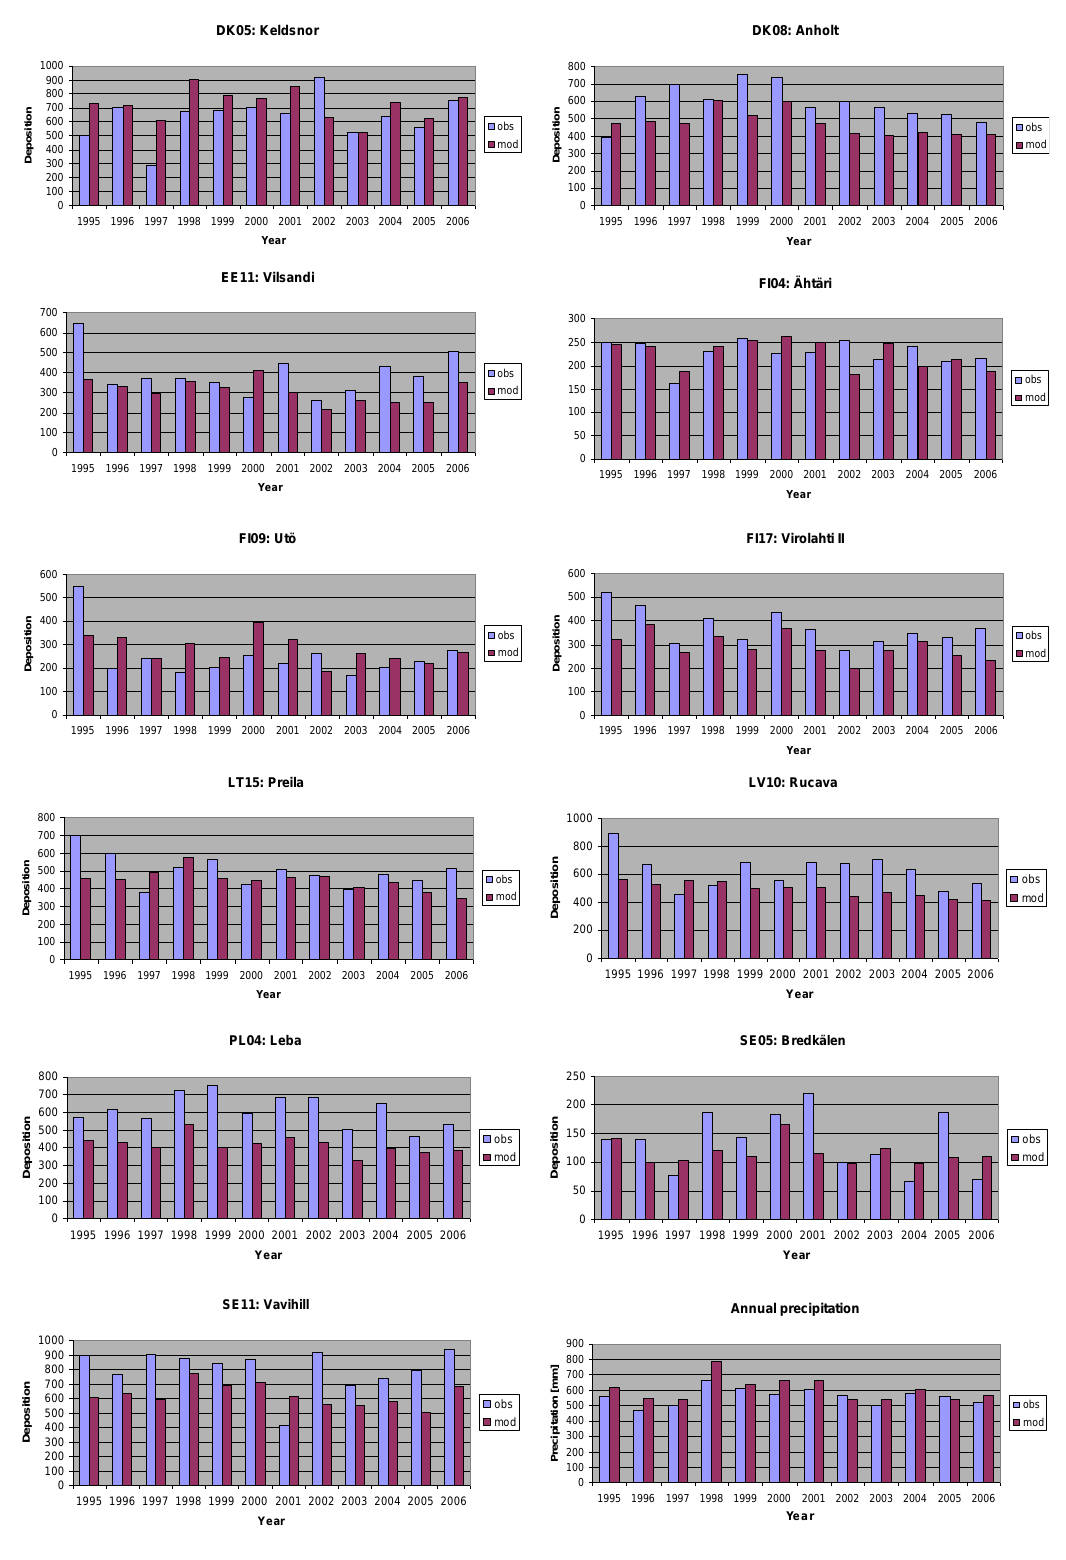
Fig. 5. Comparison of annual wet deposition based on observations (obs) at selected HELCOM stations and calculated by the EMEP model (mod) for the grid squares including these stations, for each year of the period 1995–2006. Units: mgNm − 2 . Annual precipitation to the Baltic Sea basin is also compared as average from measurements over 11 stations (obs) and average over all model grids covering Baltic Sea basin